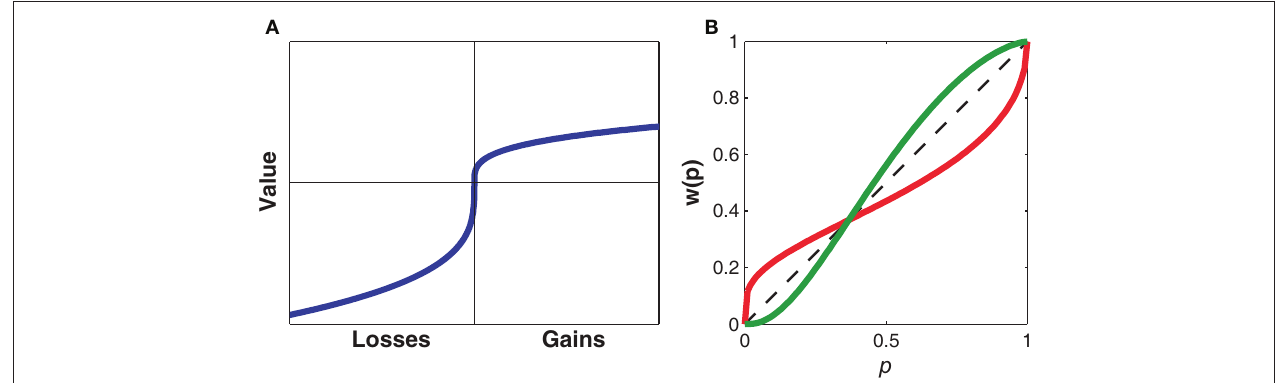
no distortion of probabilities. The probability weighting function in red illustrates overweighting of small probabilities and underweighting of large probabilities as found when using explicit probabilities, for example, in questionnaire studies. The probability weighting function in green illustrates underweighting of small probabilities and overweighting of large probabilities as found in two recent motor control studies (Wu et al., 2009; Nagengast et al.,